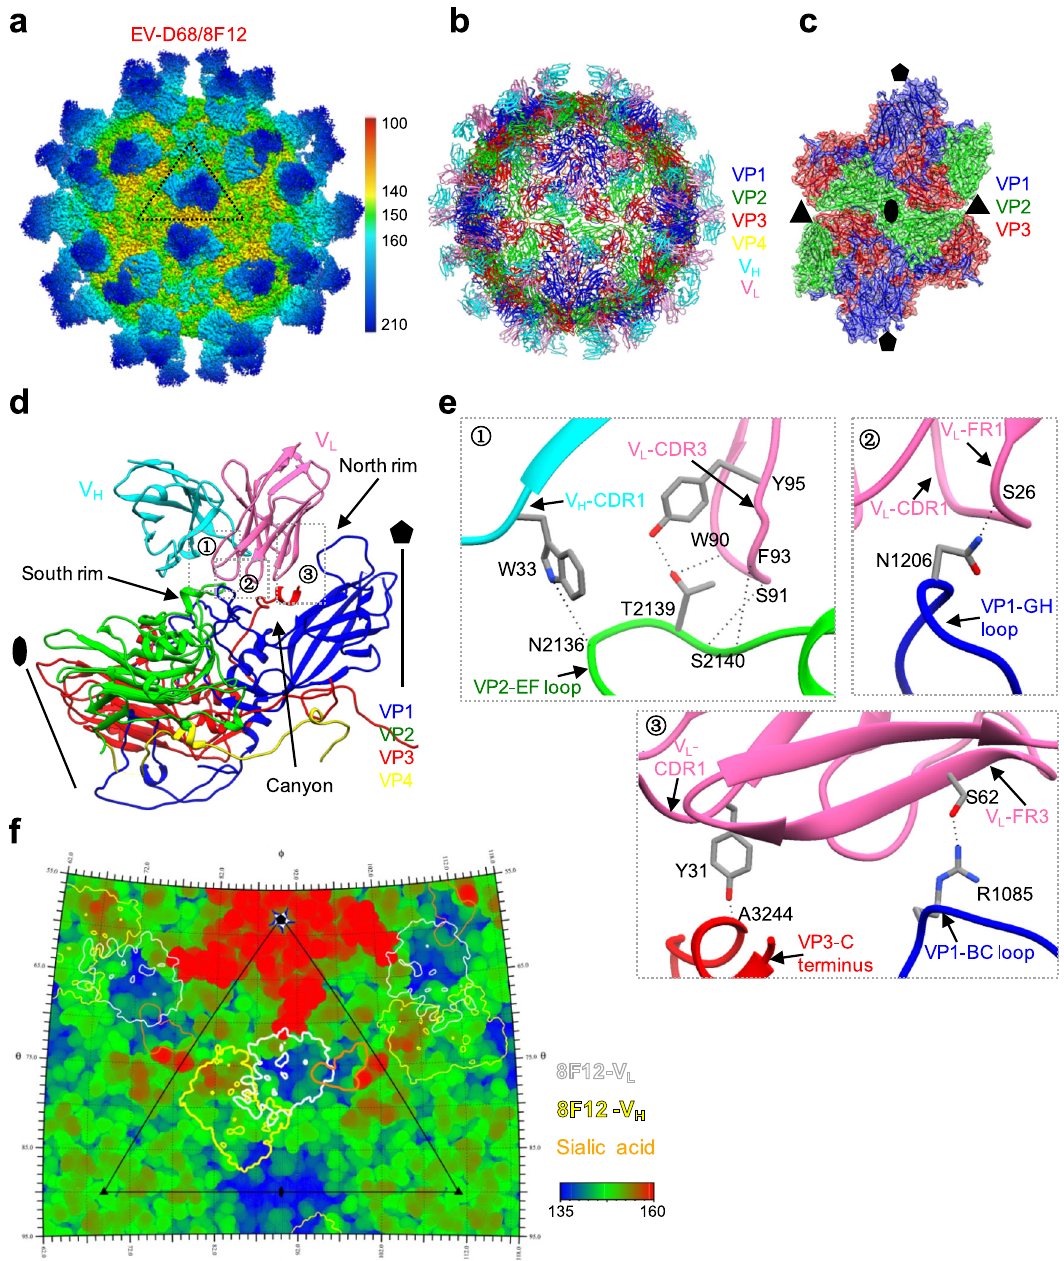
Fig. 4 Cryo-EM structure of EV-D68 in complex with 8F12 Fab. a Cryo-EM density map of EV-D68/8F12 complex viewed along the two-fold axis. The color bar indicates the corresponding radius from the center of the particle (unit in Å). The black triangle indicates one icosahedral asymmetric unit. b Atomic model of EV-D68/8F12 complex viewed along the two-fold axis. 8F12-V H , 8F12-V L , VP1, VP2, VP3, and VP4 are colored in cyan, hot pink, blue, green, red, and yellow, respectively. Models for only the variable regions of 8F12 Fab were built. c Density map with fi tted models of four adjacent protomers around the two-fold axis. 8F12 Fab was removed for clarity. The black pentagon, triangle, and ellipse represent the fi ve-fold, three-fold, and two-fold axes, respectively. d Binding Interface between EV-D68 protomer and 8F12 Fab. The canyon, north rim, and south rim are indicated by black arrows. The fi ve-fold axis is also shown. e Zoom-in views of the three dotted boxed region in Panel ( d ), showing interactions between VP2 EF loop, VP1 BC, GH loops, and VP3 C-terminus of EV-D68 and the CDR and framework (FR) regions of 8F12 Fab. The images were rotated by various angles in order to better show the interactions. Possible hydrogen bonds in the interaction interface are indicated by black dashed lines. The residues of viral proteins are identi fi ed: the fi rst digit represents viral capsid protein 1, 2, or 3, and the next three digits indicate position from the N-terminal. f Roadmap illustrating the footprints of 8F12 Fab on the EV-D68 virion surface, generated using RIVEM (Radial Interpretation of Viral Electron density Maps; reference 62 ). Polar angles θ and φ represent latitude and longitude, respectively. Viral residues are colored according to the radius. The color bar indicates the corresponding radius (unit in Å). The V L and V H are indicated by white and yellow contour lines, respectively. Footprint of the sialic acid receptor (generated using EV-D68-6 ’ SLN model, PDB: 5BNO) is also shown in orange. The icosahedral asymmetric unit is indicated by a black triangle.